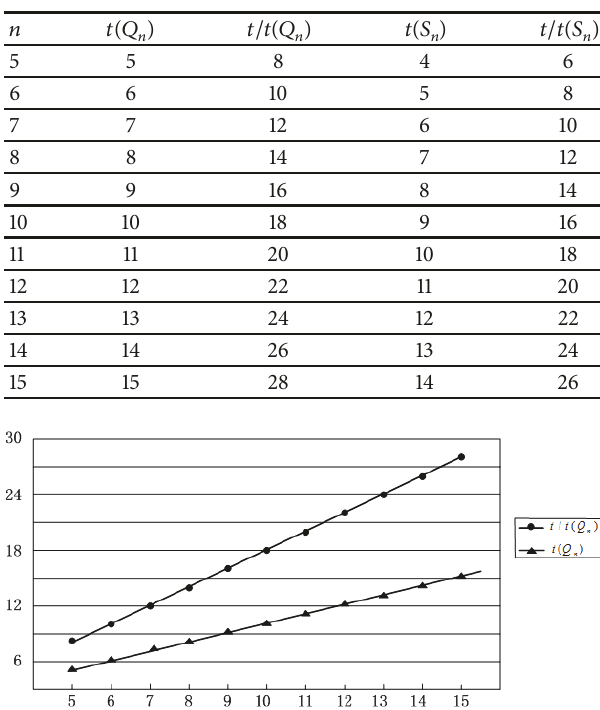
Table 1: Comparison of classical diagnosability and 𝑡/𝑡 -diagnos- ability of 𝑛 -dimensional hypercube and star network.